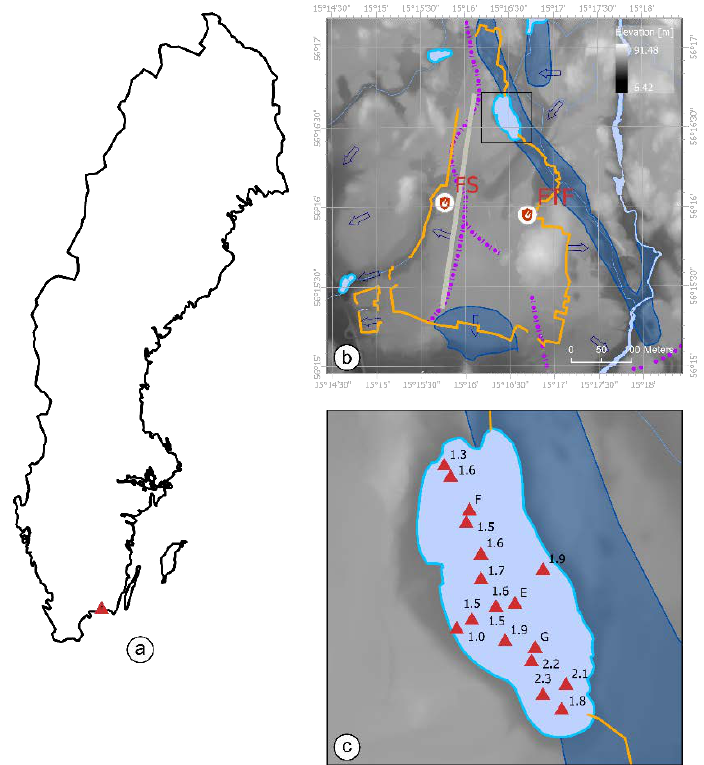
Figure 1. Study site description: ( a ) site location; ( b ) area topography and hydrogeology (including groundwater flow boundaries (purple dot-dash), flow direction (blue arrows) and reservoir (blue area)), airfield territory (solid orange), AFFF emission sources (fire station and fire training facility) and lake location (black box); and ( c ) lake bathymetry and sampling locations. GIS data: GSD Terrängkartan vektor, Lantmäteriet (base map); GSD Höjddata, Lantmäteriet (topography) and SGU Grundvattenmagasin and Grundvatten, SGU (hydrogeology).